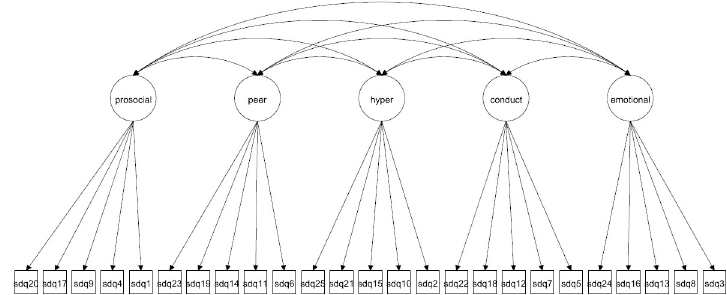
Fig 9. 5-factor model (Model